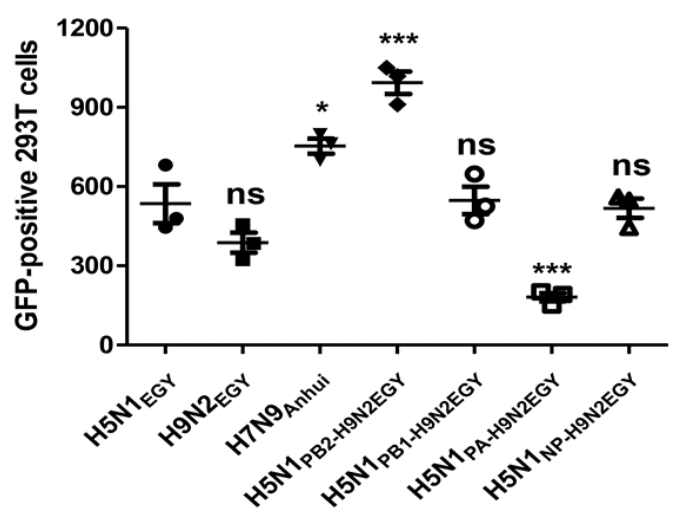
Figure 3. In vitro polymerase activity in human 293T cells. 293T cells were transfected with plasmids expressing the three subunits (PB2, PB1, and PA) of the viral RNA-dependent RNA polymerase (RdRp) and the viral nucleoprotein (NP) of H5N1 EGY , H9N2 EGY, H7N9 Anhui or combinations of H5N1 EGY RdRp subunits with single RdRp subunits of H9N2 EGY . Along with the three RdRp subunits and NP expressing plasmids, a vector expressing a vRNA-like Pol-1 transcript encoding the reporter GFP gene was co-transfected. At 48 h p.t., the control and the transfected cells were analyzed for percentage of GFP positive cells. The significance was tested using one-way ANOVA, followed by Dunnett’s multiple comparison post hoc test and the significant differences are indicated (* = p < 0.05, *** = p < 0.001 and non-significant = ns).